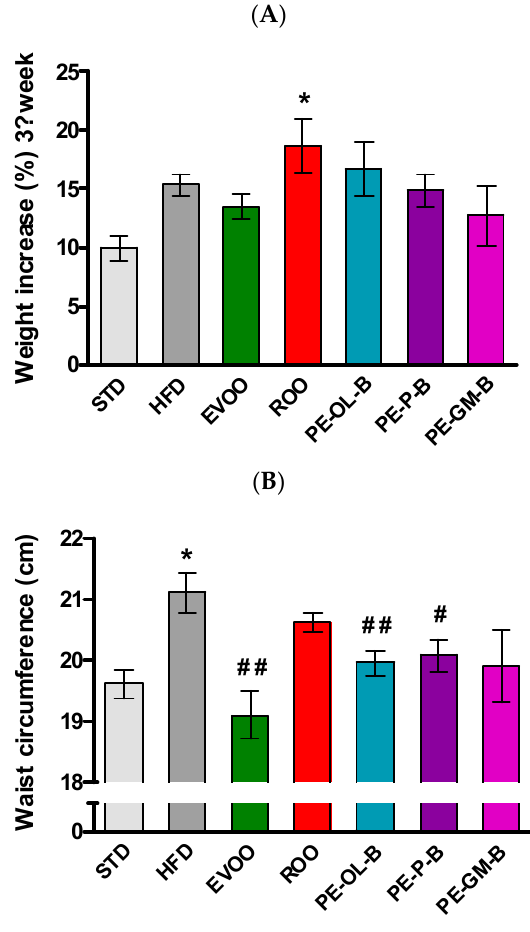
Figure 3. ( A ) Body weight gain of the animals at the third week of treatment (end of treatment). ( B ) waist circumference measured at the end of treatment. * indicates a statistically significant di ff erence between the HFD group and the STD group. # indicates statistically significant di ff erence vs. HFD. Single symbol corresponds to p ≤ 0.05. Double symbol corresponds to p ≤